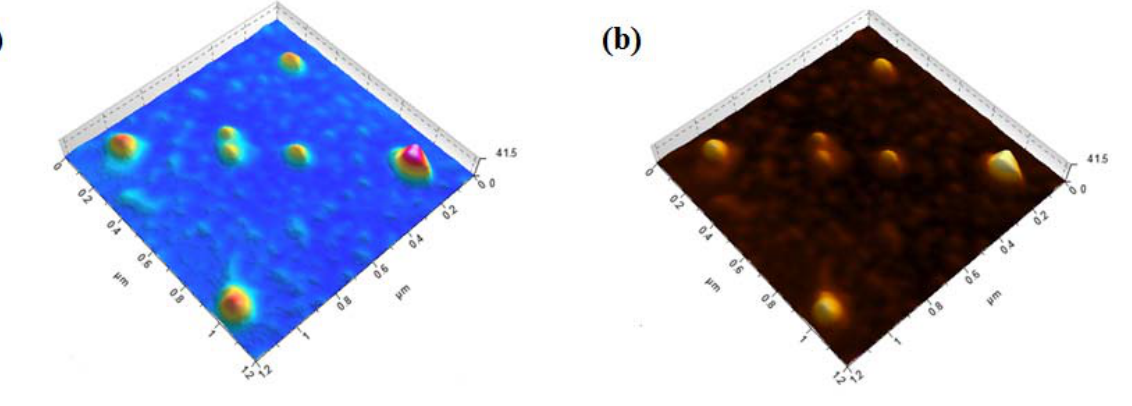
Figure 3. AFM ( a , b ) 3D images of the starch-based AC.